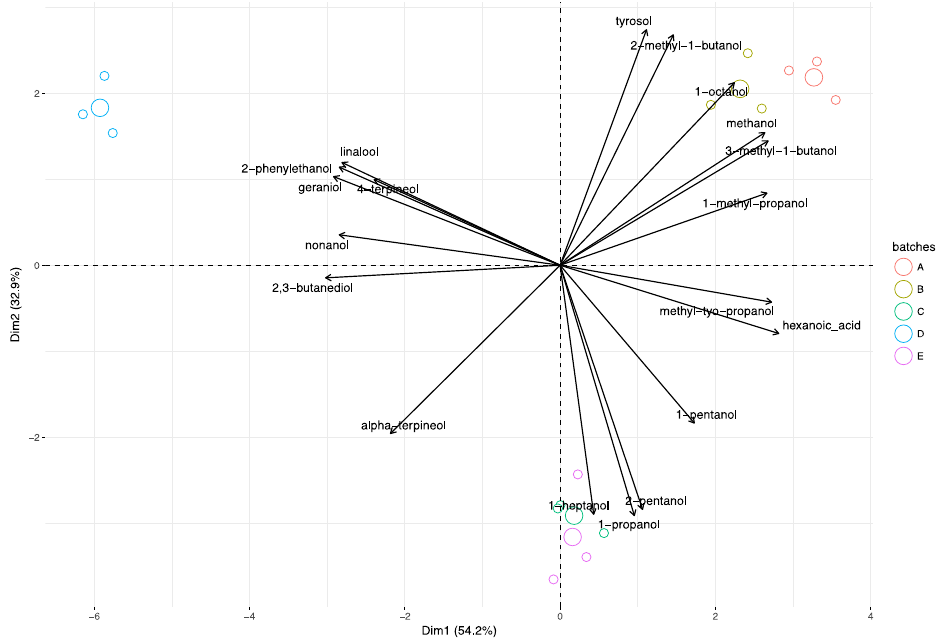
Figure 4. Principal components analysis (PCA) ‐ biplot of volatile compounds in different batches at the end of the winemaking process. The big circles represent the mean values of three independent experiments.